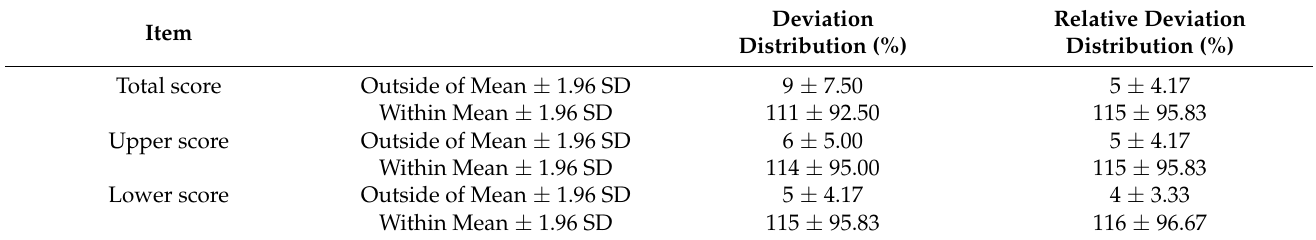
Table 5. Analysis of data distribution of deviation and relative deviation between intelligent rehabili- tation assessment system score and physician’s Fugl–Meyer